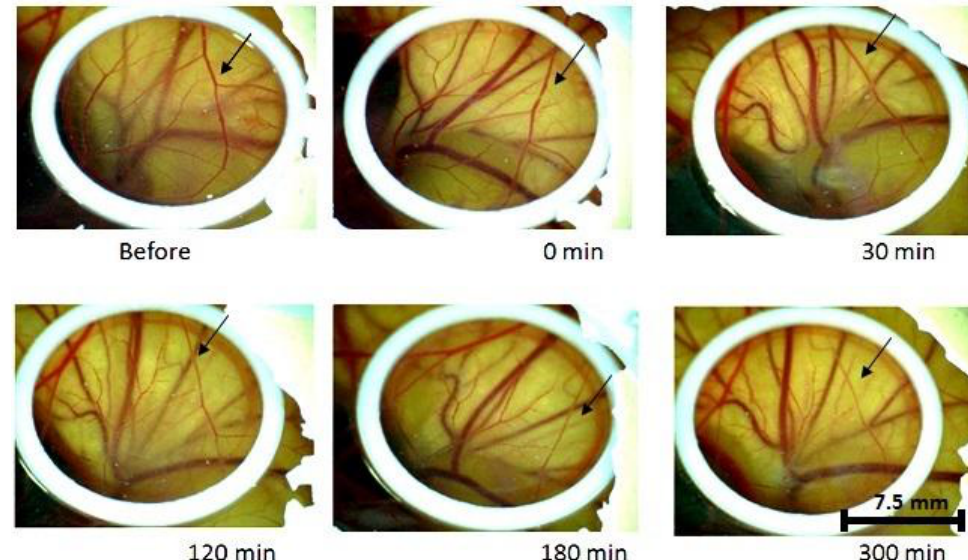
Figure 1. Only Curcumin (0.1 mM) effect over the time without light. The arrows point out a vessel that became thinner over time.